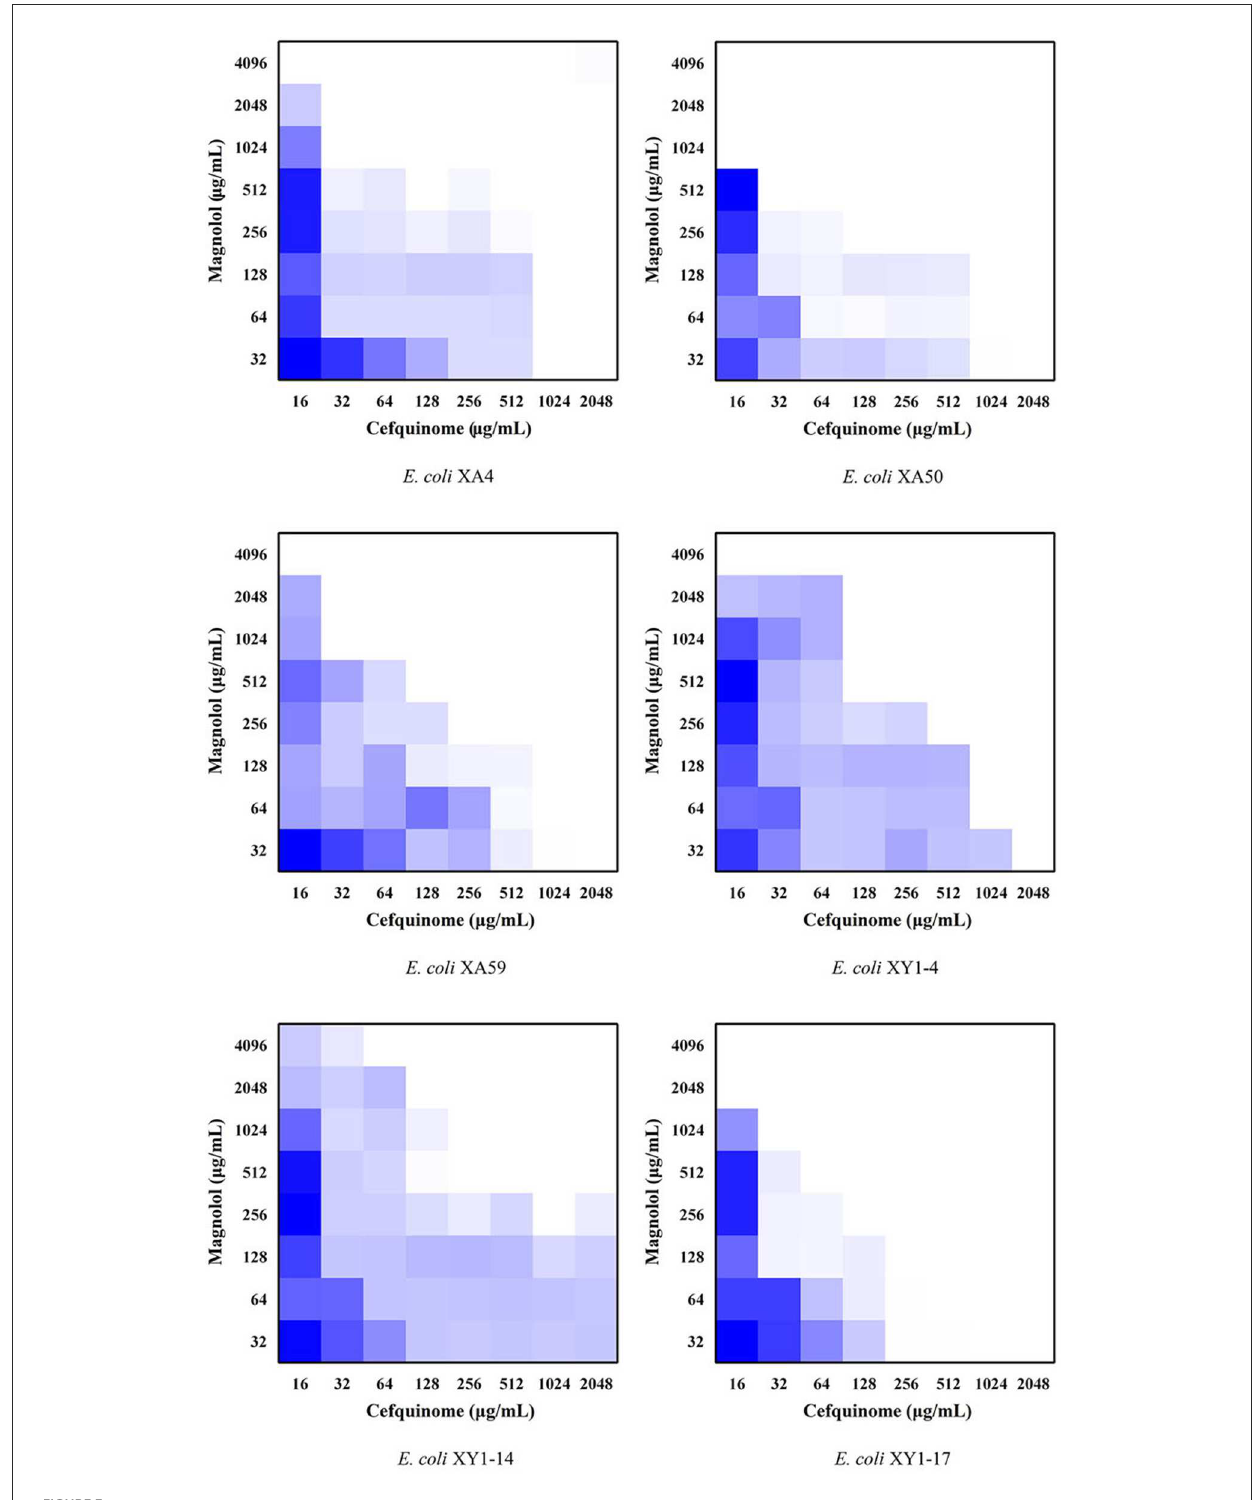
FIGURE3 Checkerboard broth assays for magnolol and cefquinome against 6 MDR E. coli strains.